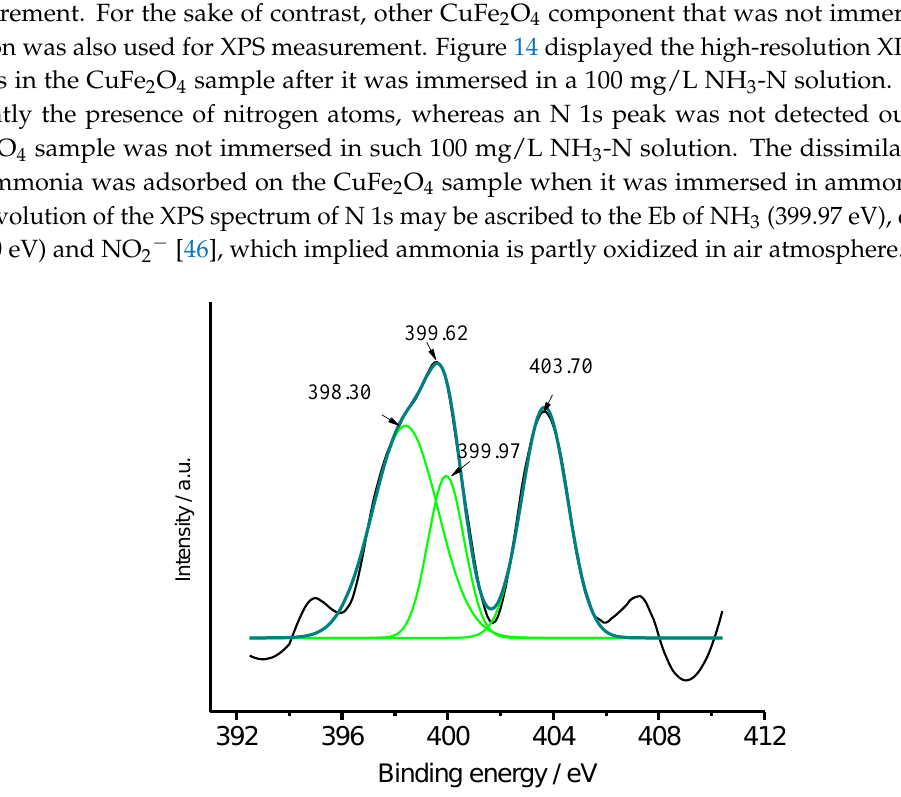
Figure 14. High-resolution XPS spectrum of N 1s on the CuFe 2 O 4 sample after it was immersed in 100 mg/L NH 3 -N solution.